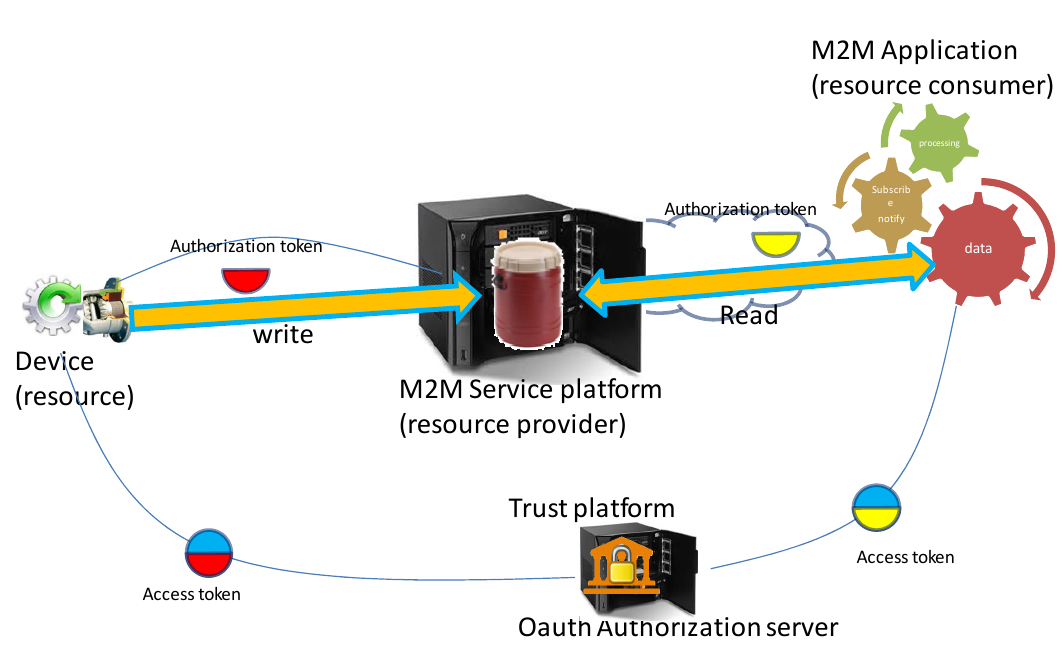
Figure 16. Achieving End-to-End security for M2M